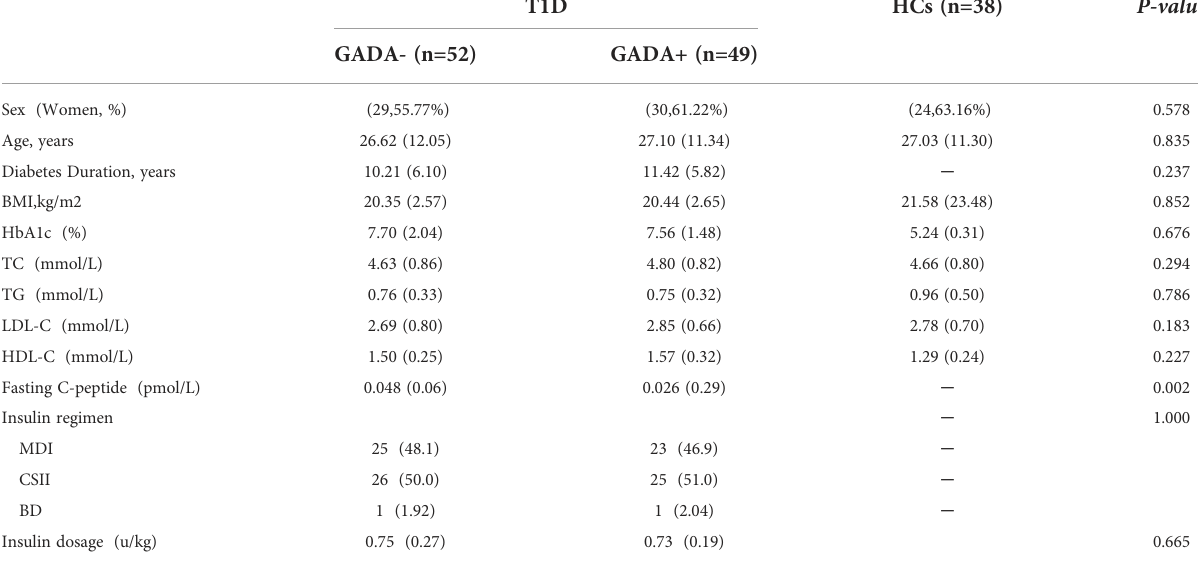
TABLE 1 Characteristics of the